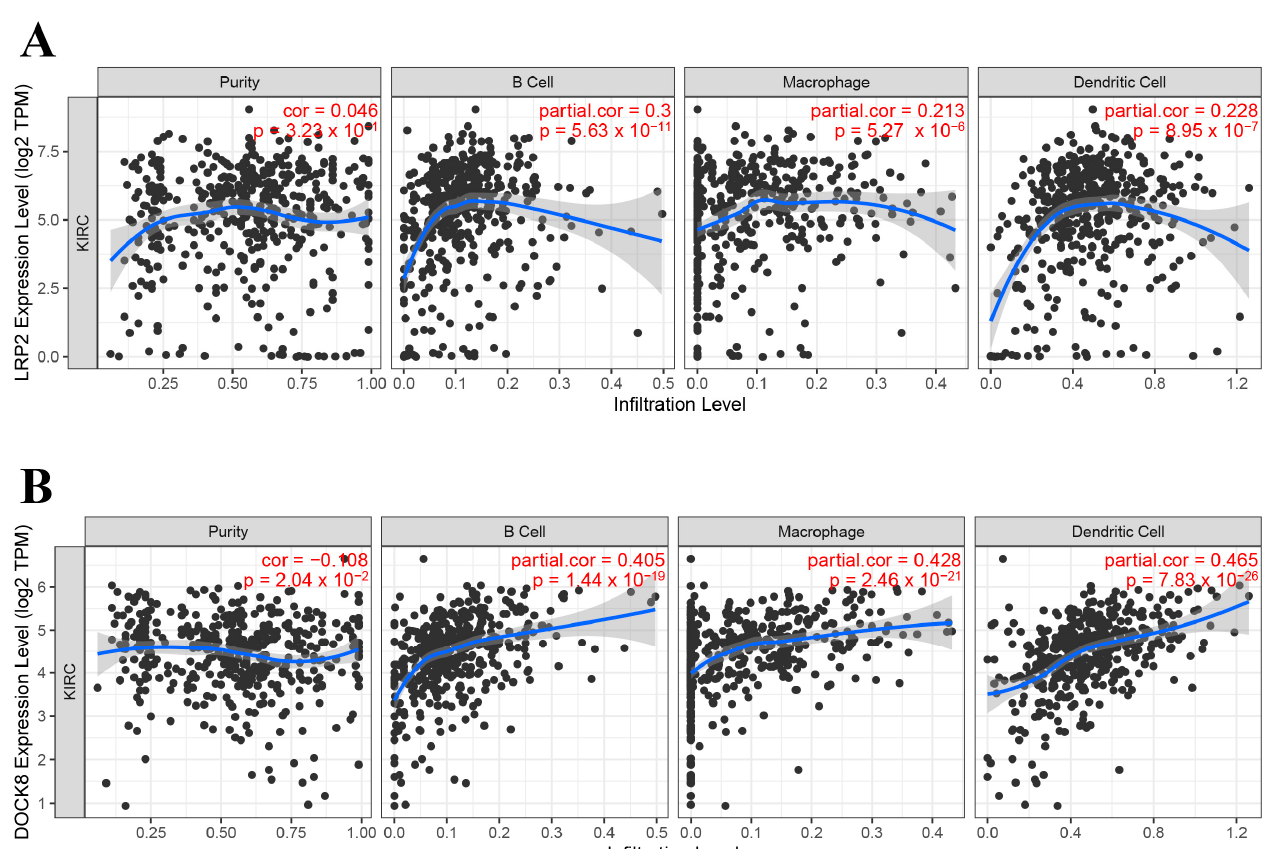
Figure 3. The expression of tumour antigen in clinical tumour patients. The expression of DOCK8 ( A ) and LRP2 ( B ) in tumour and normal tissues of 19 KIRC patients; (** p < 0.01).